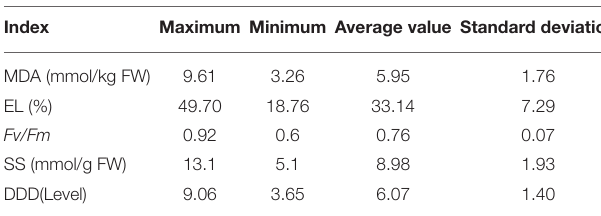
TABLE 1 | Descriptive statistics of drought-induced components and drought damage degree of total fresh leaf